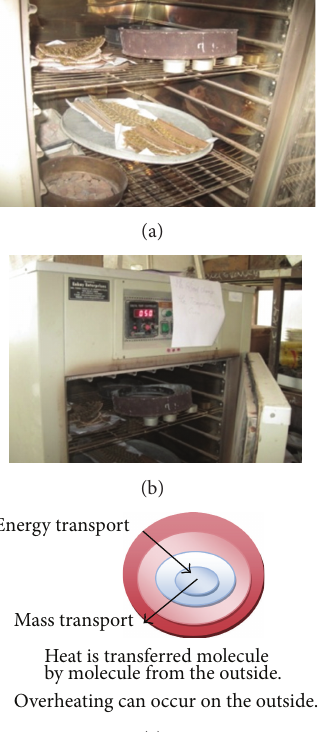
Figure 1: (a) samples in oven for thermal conditioning; (b) thermo- statically controlled oven; (c) mechanism of convection heating.